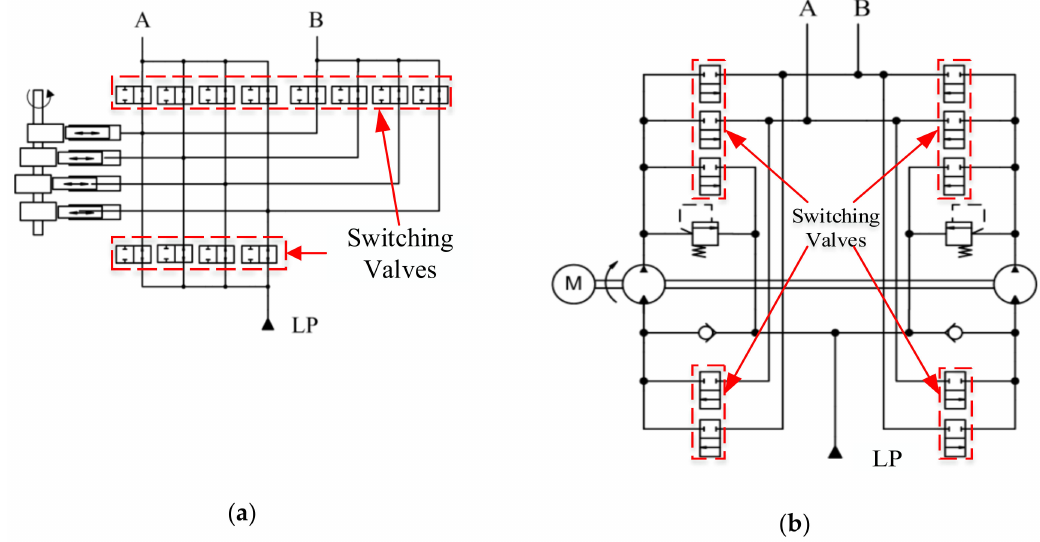
Figure 13. Digital hydraulic power control system: ( a ) piston type digital hydraulic power control system (DHPMS); ( b ) quantitative pump-motor type